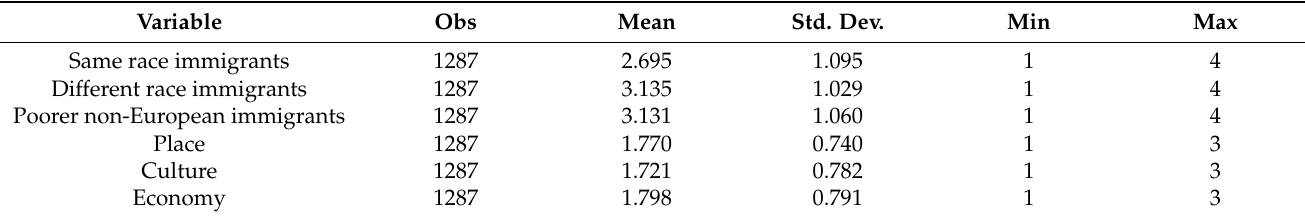
Table 1. Summary statistics of the dependent